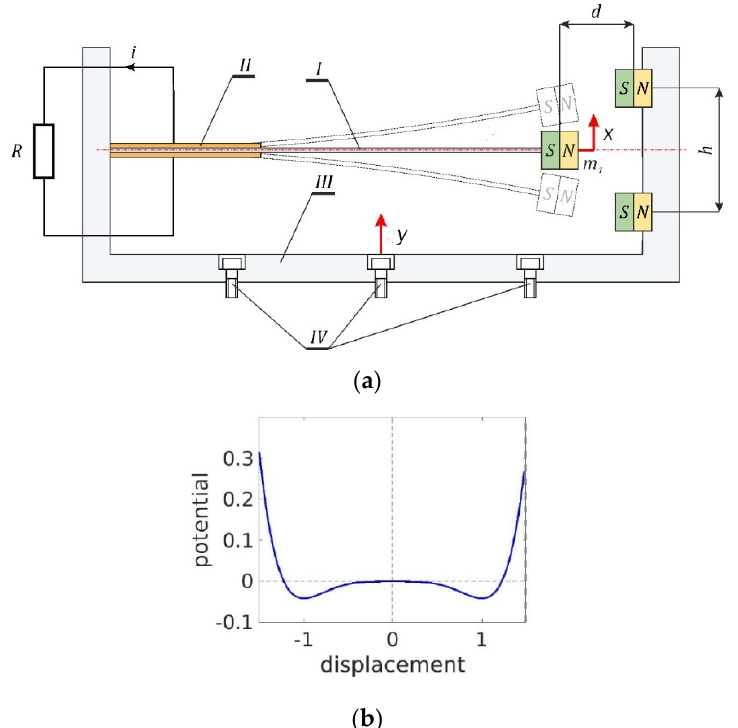
Figure 1. ( a ) Scheme of the energy-harvesting model: the cantilever beam ( I ), the rigid frame ( III ) with the bolts ( IV ) mounted to the kinematic forcing, and the piezoelectric transducer ( II ) . x and y denote the directions of the frame motion and the tip magnet motion in reference to this frame, respectively. The configuration of permanent magnets makes it possible to model the potential presented in the non-dimensional form ( b ). d and h are used in the system to characterize and scale the units of displacement. R and i correspond to the load resistor and current in the electrical circuit attached to the piezoelectric